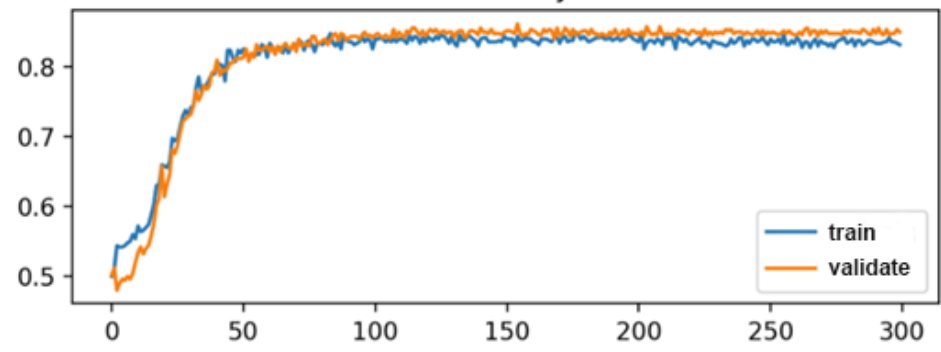
Figure 8. The plots for iterations versus accuracy for the training and validation data sets.